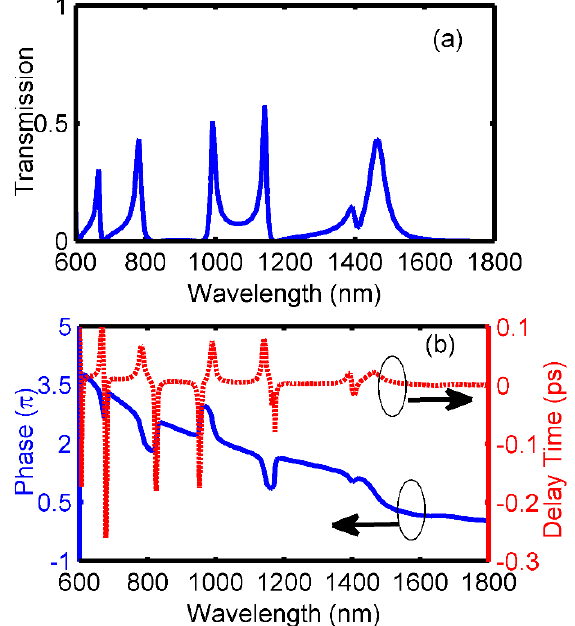
Figure 8. Fano resonances after adding cavity D ( a ) Transmission spectrum, ( b ) Phase responses (blue solid line) and group delays (red dash line).